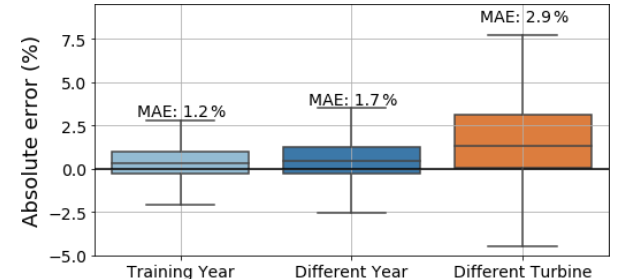
Figure 12. DEL prediction error for validation (training year and different year) and cross-validation, expressed as a percentage of the maximal DEL. Error expressed as a percentage of the absolute maximal training DEL